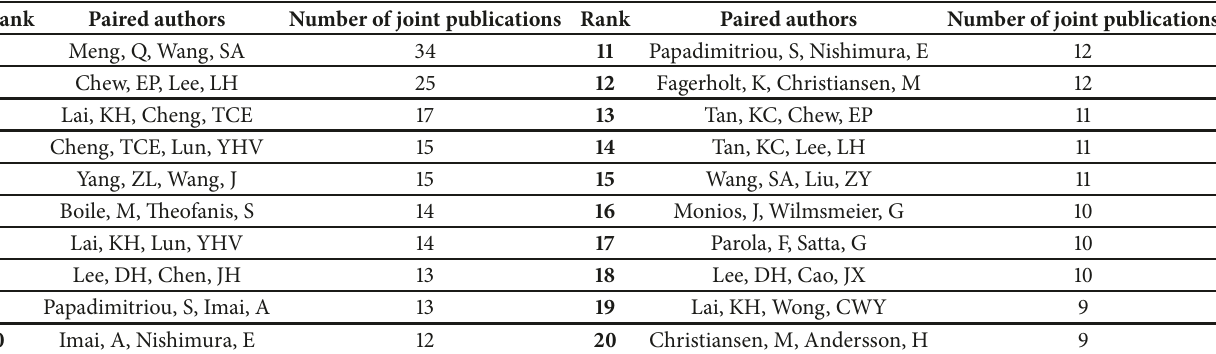
Table 4: The most prolific paired authors.